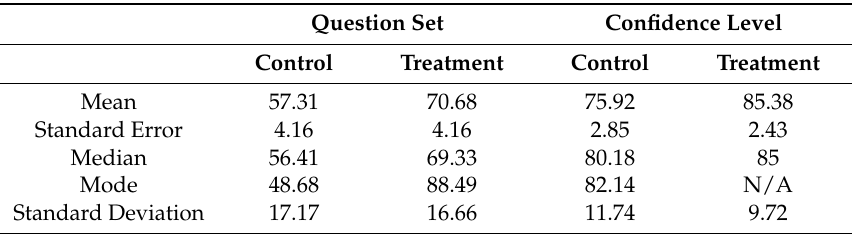
Table 2. Overall descriptive statistical summary for the visualization literacy